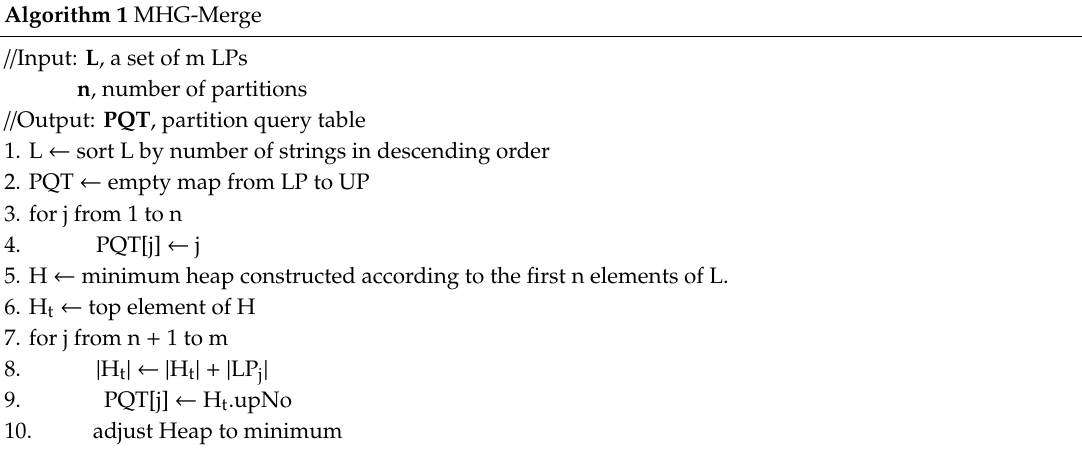
Algorithm 1. Min-Heap based Greedy Merging (MH-GMerge) algorithm. Algorithm 1